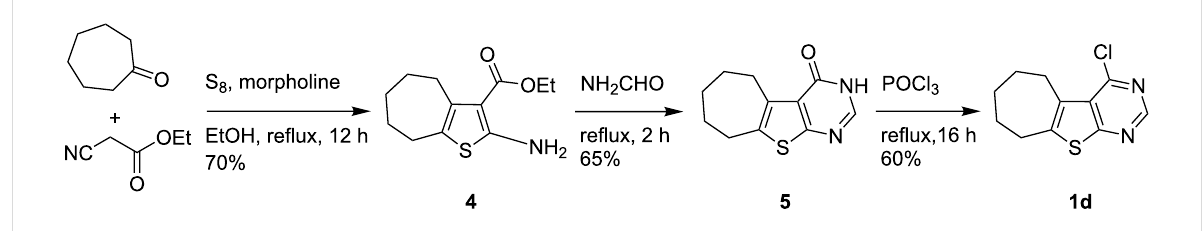
Scheme 2: Preparation of 4-chloro-6,7,8,9-tetrahydro-5 H -cyclohepta[4,5]thieno[2,3- d ]pyrimidine 1d